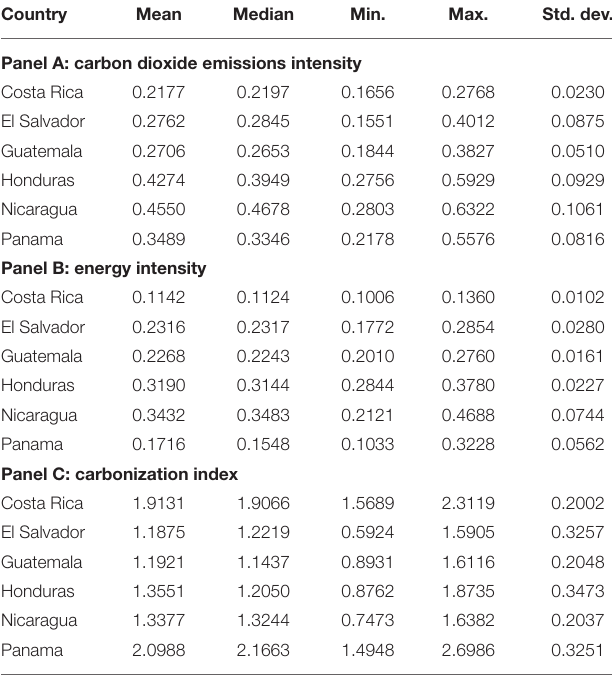
TABLE 1 | Summary statistics.